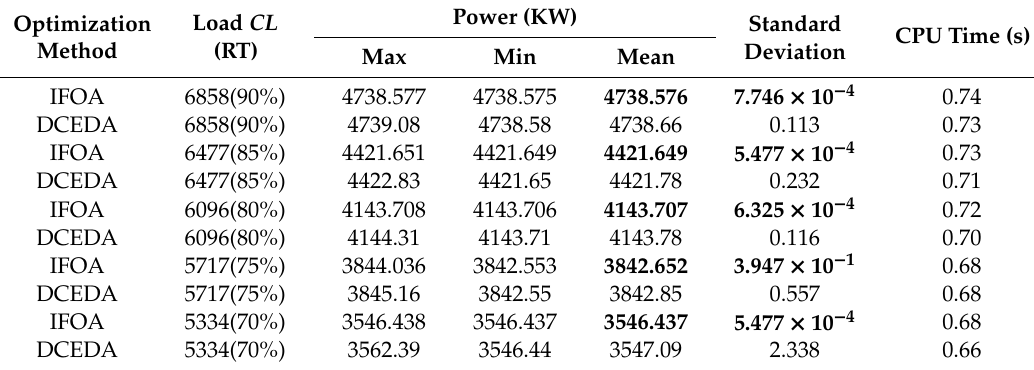
Table 6. Results of objective function in 30 runs in case 1.